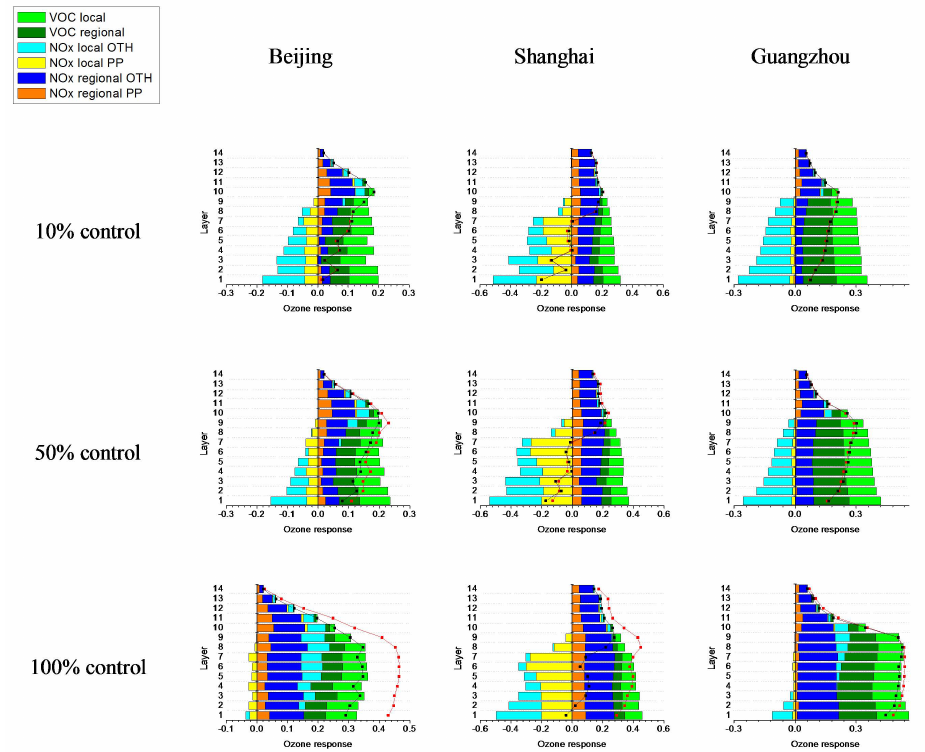
Fig. 12. Vertical profile Ozone response to the stepped control of individual source category in 3 cites. (Ozone response = Change ratio of Ozone/Change ratio of Emission; red solid lines indicate synchronous control on all source categories; colored columns are ozone response to the changes of each source category; grey solid lines indicate sum of separate control on each source category; the heights of layers 1–14 above ground are 36, 72, 145, 294, 444, 674, 1070, 1568, 2093, 2940, 3991, 5807, 9057, 14648m respectively; all values are averaged of ozone during afternoon time, 12:00–17:00 in July,